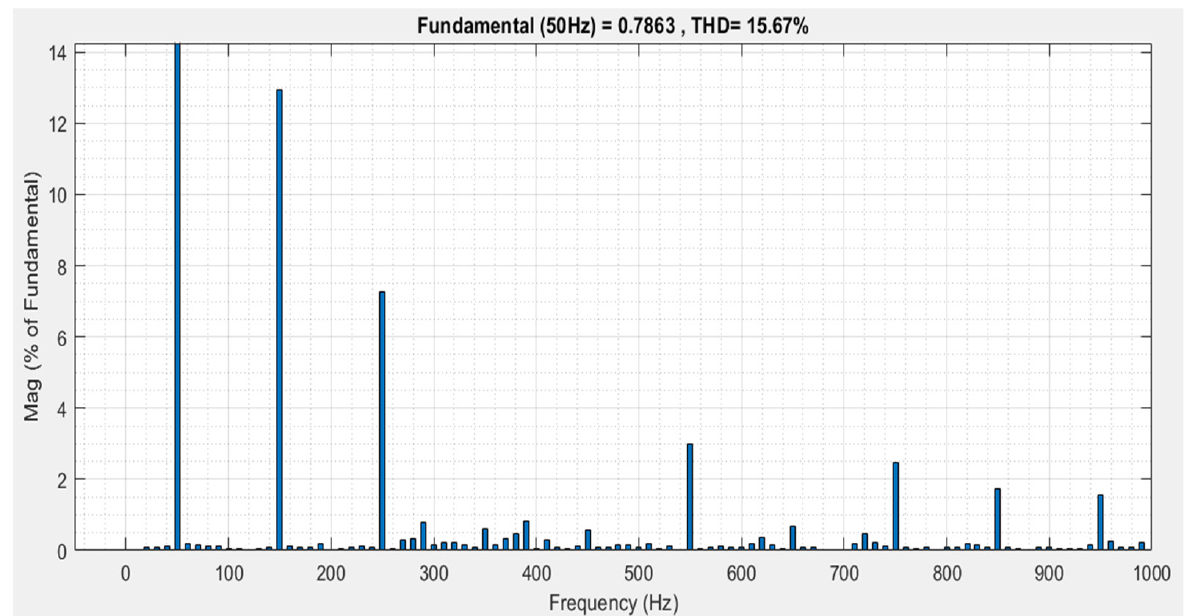
Figure 20. DMCC profile for two converters with inductor currents with proposed controller.